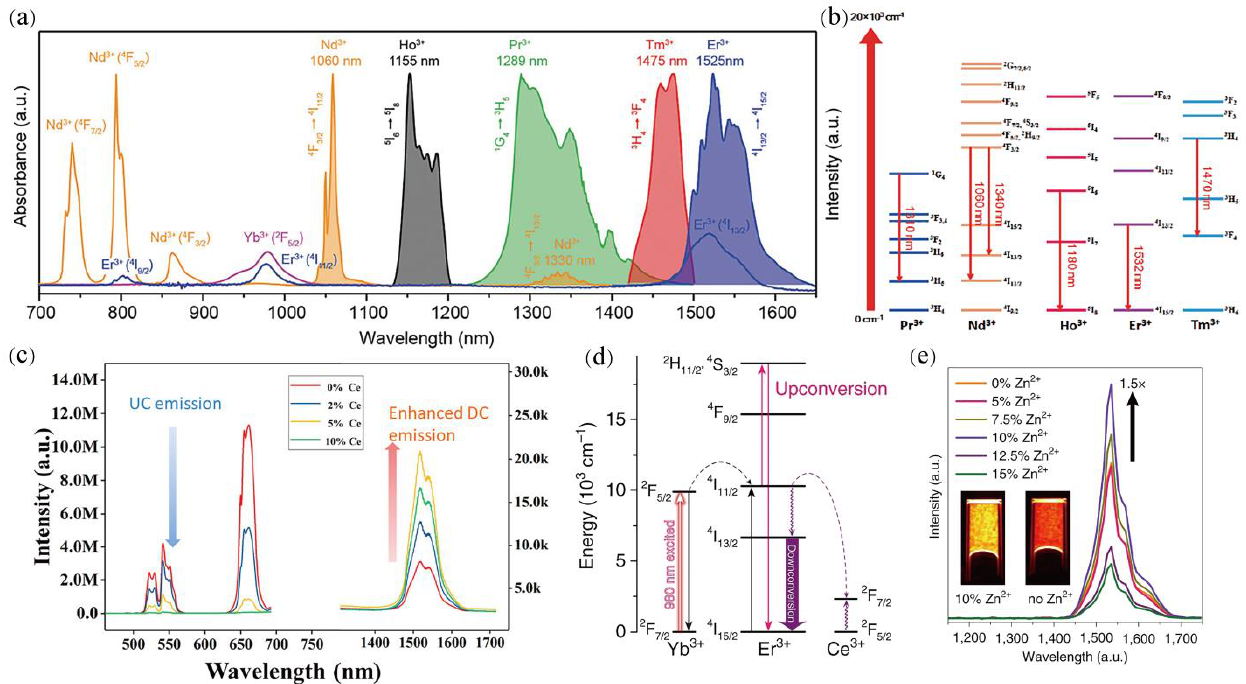
Figure 3. ( a ) Absorption (solid line) and NIR−II emission (solid line with color shade) spectra